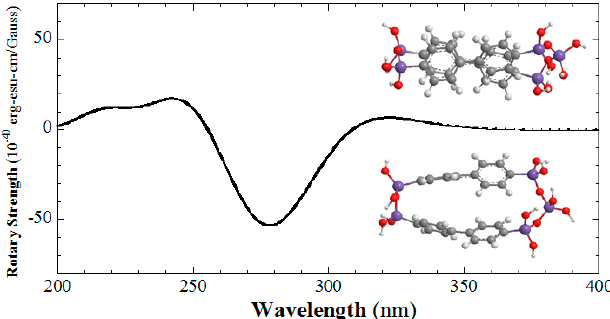
Figure 8. Simulated CD spectrum of the right-handed twisted and stacked biphenylene rings of the 4,4 ′ -biphenylene-bridged bis(silsesquioxane) dimer.